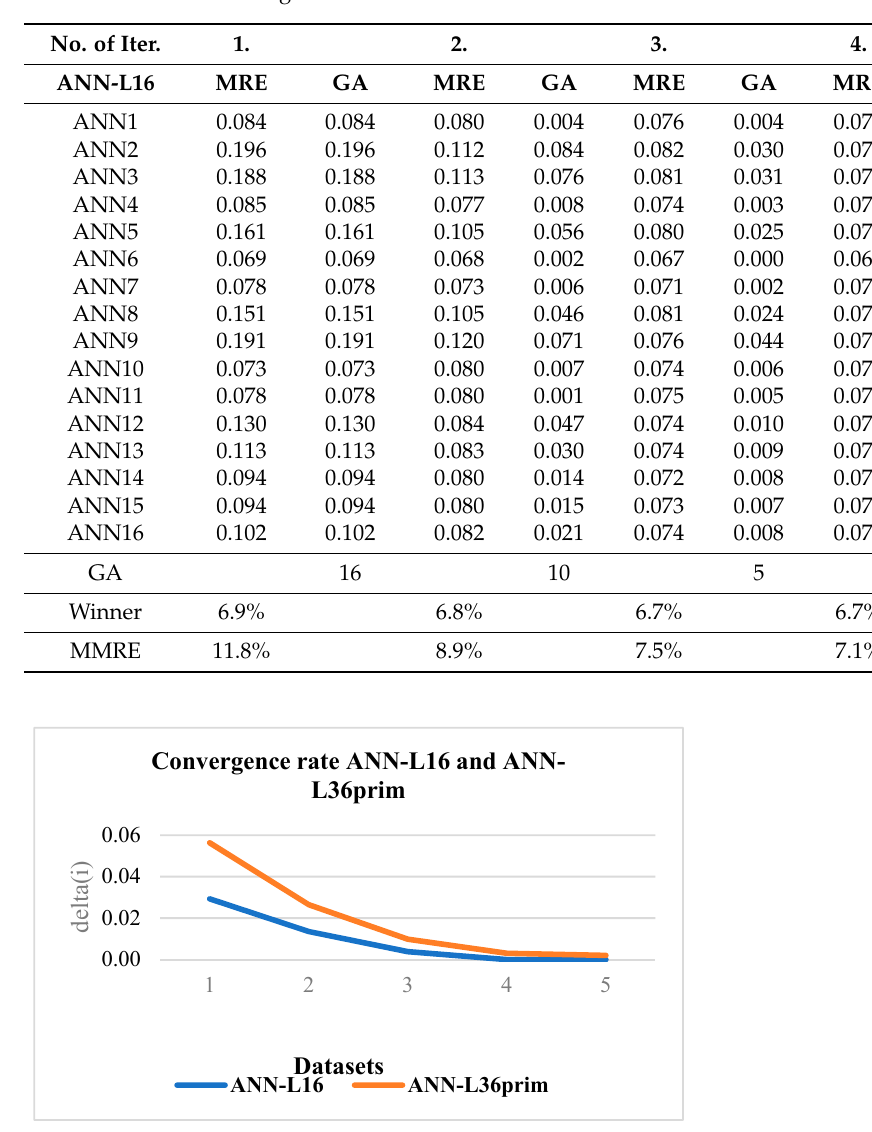
Table 5. ANN-L16 training results.